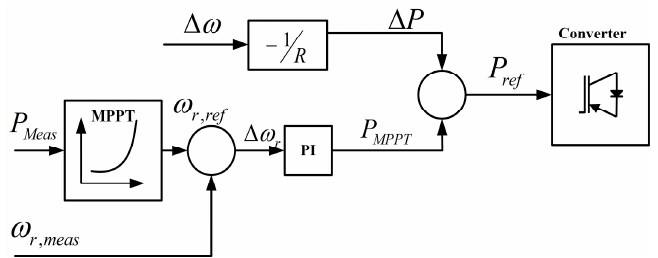
Figure 11. Droop control for wind turbine.